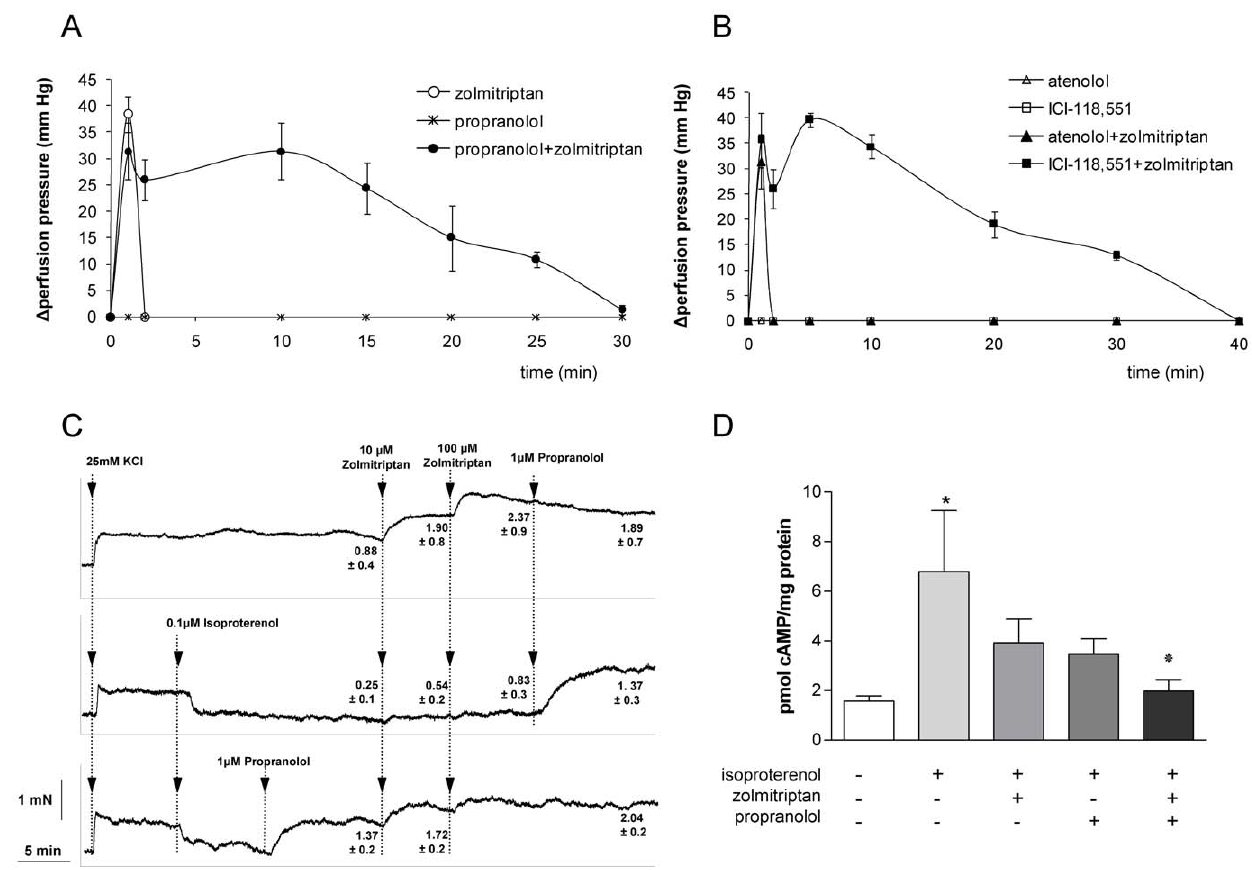
Figure 5. Effects of zolmitriptan in combination with beta-blockers on splanchnic vasculature of healthy rats. (A,B) Zolmitriptan alone or in combination with propranolol, atenolol and ICI-118,551 were administered intra-arterially and perfusion pressure recorded. (C) In vitro mesenteric artery contraction studies after zolmitriptan and propranolol administration in the presence or absence of isoproterenol. (D) cAMP measurement in mesenteric artery wall after administration of zolmitriptan, propranolol or the combination or both in the presence of isoproterenol. */*p , 0.05 vs control group/group receiving only isoproterenol.